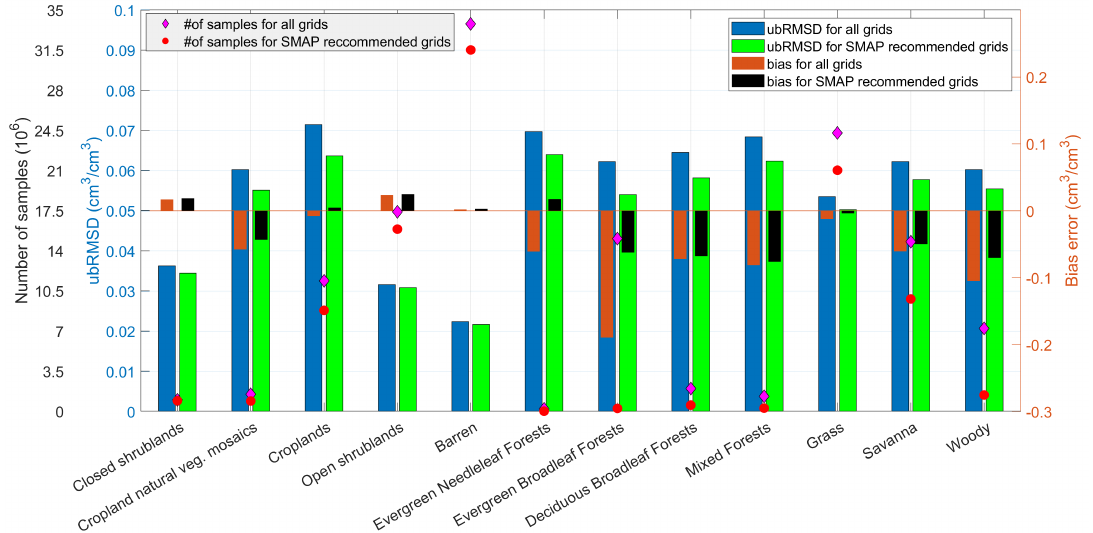
Figure 7. Evaluation of the model for different land cover types. The left axis is for ubRMSD and the right axis is for bias